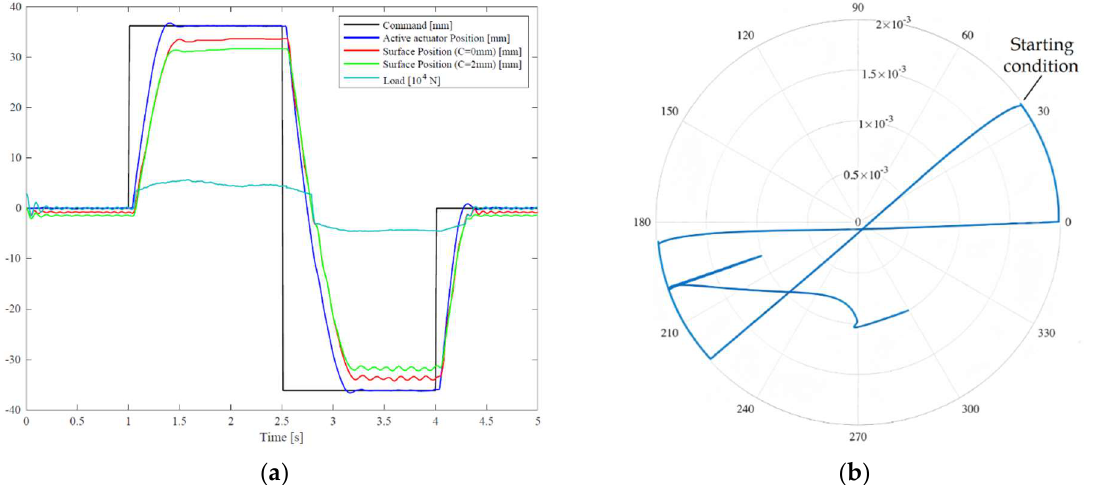
Figure 9. Simulation results of a rod-end with a high backlash of 2 mm connecting 2 servo-actuators to the control surface: ( a ) Pin trajectory within the rod-end housing during the simulation; ( b ) Com- parison between the surface position obtained with (green) and without (red) backlash in the rod-end (© 2021 ASME. Reprinted, with permission, from [40]).